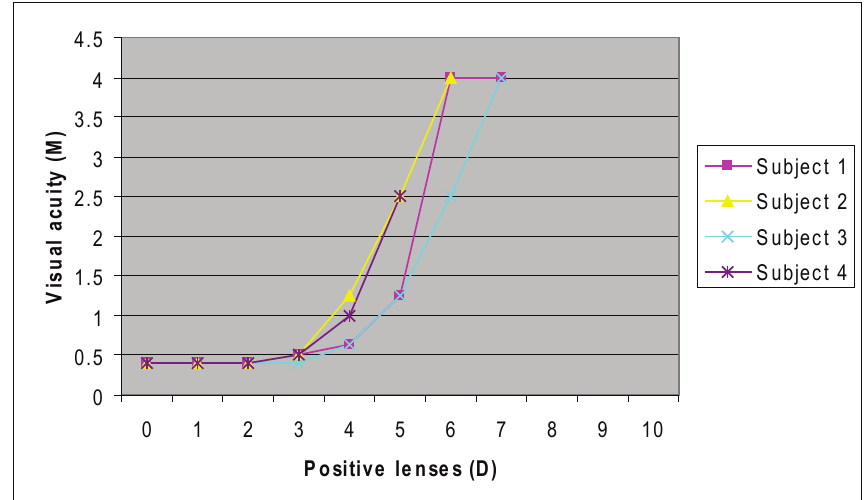
Figure 1. Effect of positive lenses on visual acuity while viewing a near acuity chart at 0.4 m, without a pinhole, illuminated at 460 lux. M notation is used for all plots and on this scale 6/6 = 0.4 and 6/60 = 4 M.